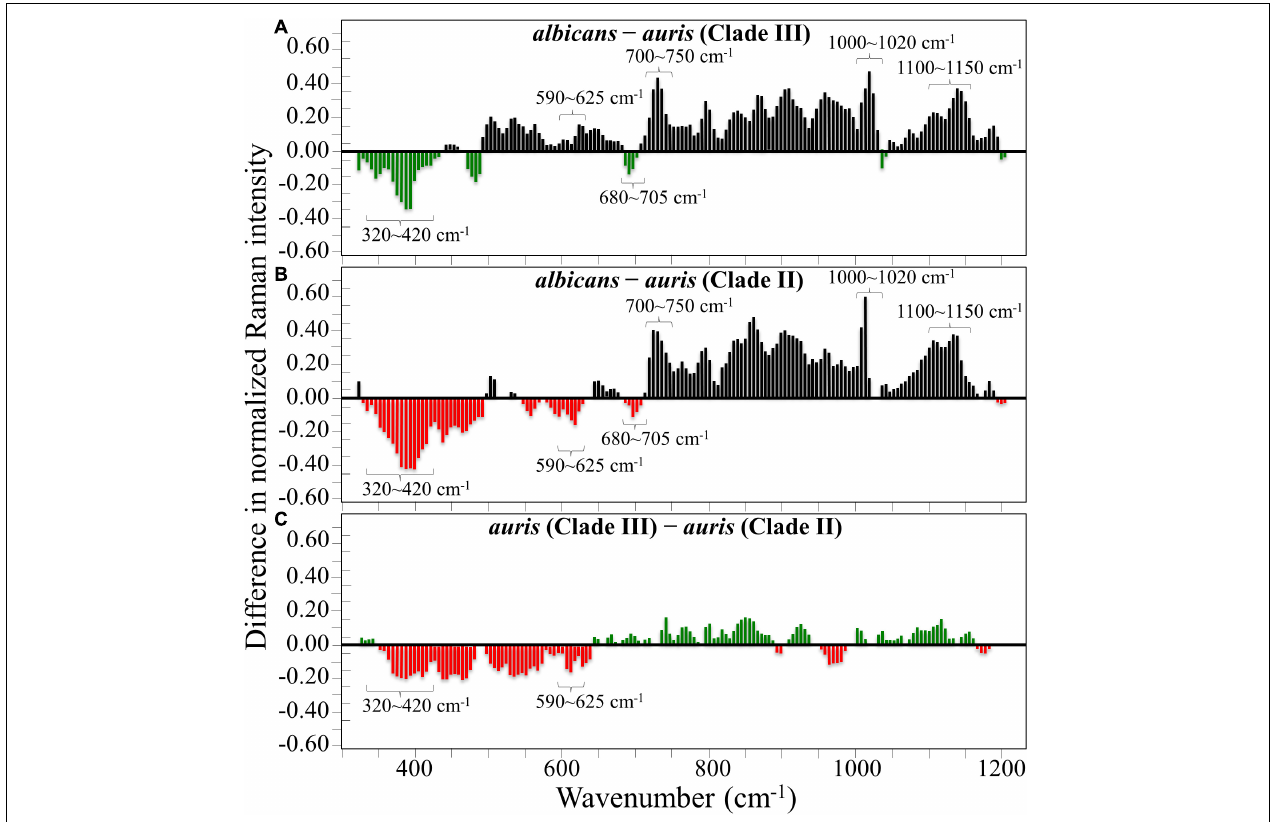
FIGURE 2 | Results of subtraction of the average normalized spectra in Figure 1 : (A) subtraction of the C. auris (Clade III) spectrum from the C. albicans spectrum; (B) subtraction of the C. auris (Clade II) spectrum from the C. albicans spectrum; (C) subtraction of the C. auris (Clade II) spectrum from the C. auris (Clade III)